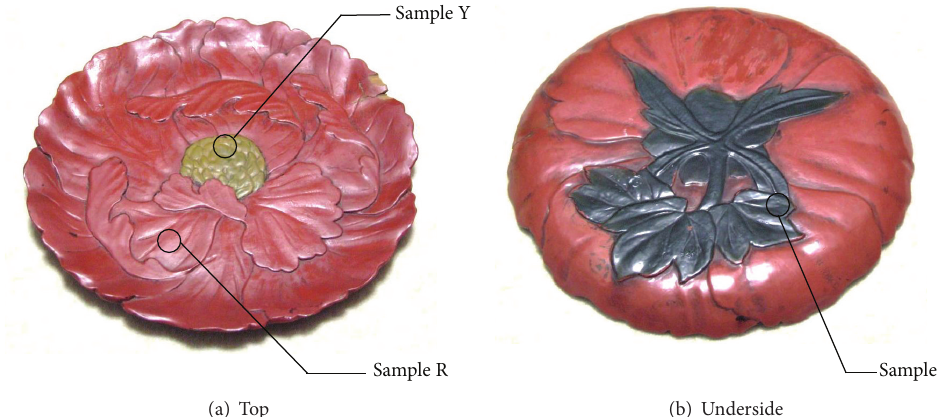
Figure 1: Photographs of a Kamakura-bori tray decorated with a peony design (diameter: 31 cm); (a) top, (b) underside. Locations of collected samples ( I ) are